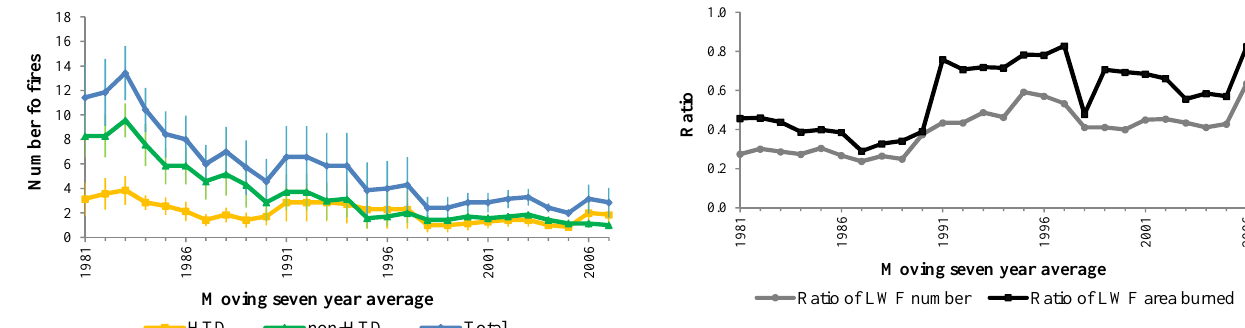
Fig. 4. Ratio of LWF area burned under HTDs versus total area Figure 4. Ratio of LWF area burned under HTD versus total area burned and ratio of LWF2 burned and ratio of LWF number under HTDs versus total number number under HTD versus total number of LWF in Aragón from 1978 to 2010. Moving3 of LWFs in Arag´on from 1978 to 2010. Moving seven-year average from 1981 to seven-year average from 1981 to 2007.4